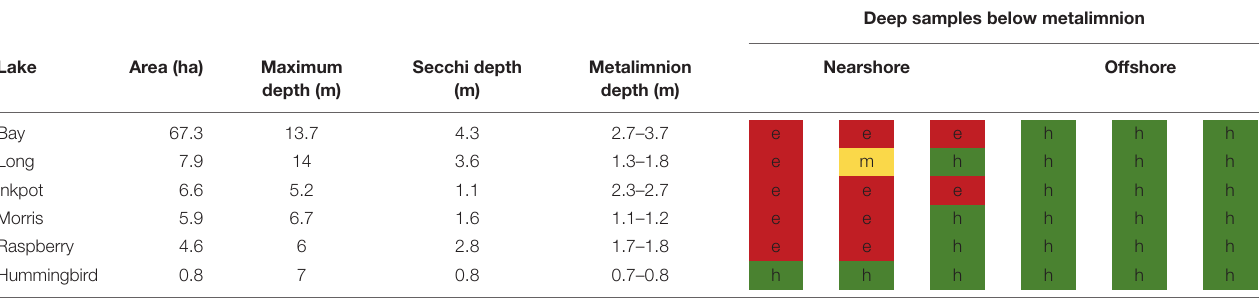
TABLE 1 | Characteristics of lakes sampled at the University of Notre Dame Environmental Research Center (UNDERC), Michigan, United States, for environmental DNA metabarcoding during the summer of 2015.